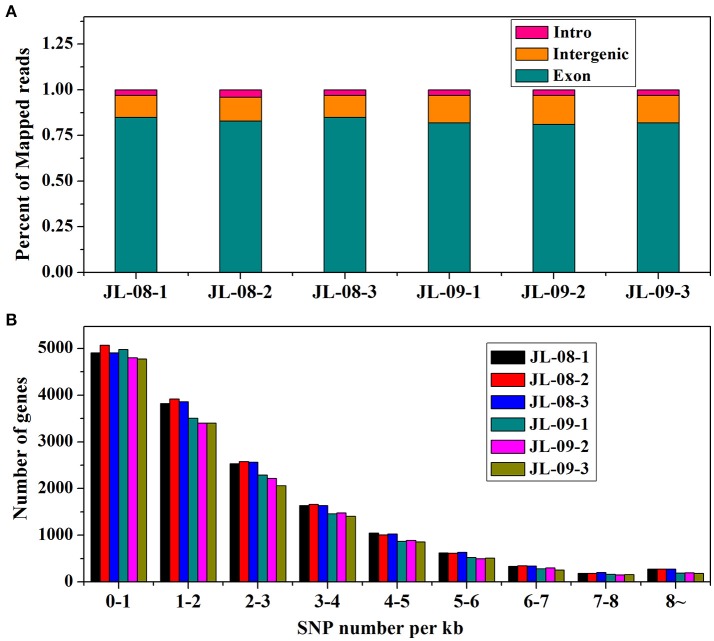
(A) The percent of mapped reads distributed in different sites (intro, intergenic, and exon) of gene in JL-08 and JL-09. The X axis represented three repetitions of sequenced JL-08 and JL-09, respectively. JL-08-1, JL-08-2, and JL-08-3 are three repetitions of JL-08. JL-09-1, JL-09-2, and JL-09-3 are three repetitions of JL-09. The Y axis is the percent of mapped reads distributed in different sites of gene. Pink column: intro; Yellow: intergenic; Cyan: extron. (B) The SNP density values on specific length gene in JL-08 and JL-09 sprouts. The X axis represented nine gene length ranges (0–1 kb, 1–2 kb, 2–3 kb, 3–4 kb, 4–5 kb, 5–6 kb, 6–7 kb, 7–8 kb, and 8~ kb). The left axis is the number of SNP loci based on gene length in three repetitions of sequenced JL-08 and JL-09, respectively. JL-08-1, JL-08-2, and JL-08-3 are three repetitions of JL-08. JL-09-1, JL-09-2, and JL-09-3 are three repetitions of JL-09. Black, JL-08-1; Red, JL-08-2; Blue, JL-08-3; Cyan, JL-09-1; Pink, JL-09-2; Yellowish green, JL-09-3.